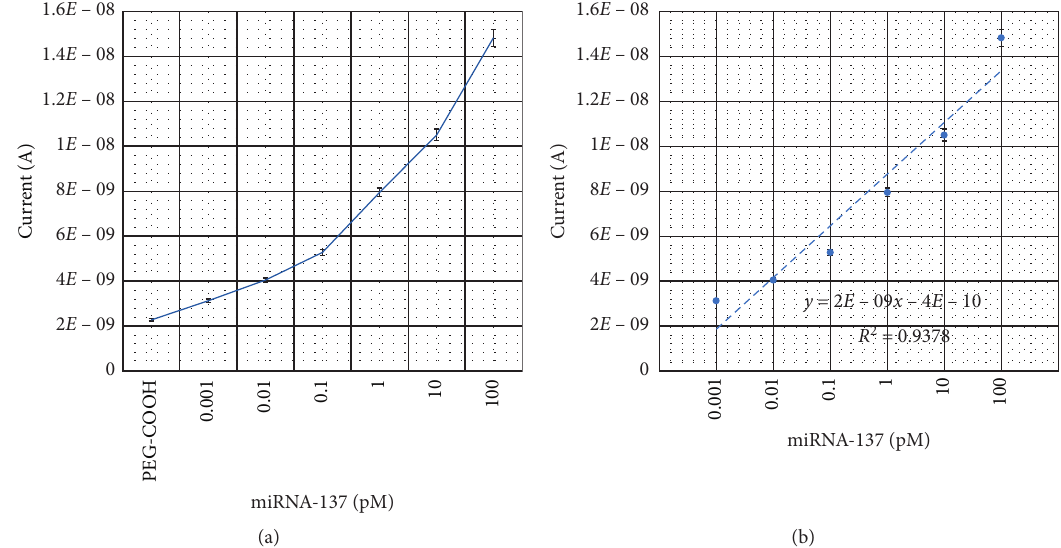
Figure 4: (a) Current response of miRNA-137 hybridization. With increasing target miRNA-137 concentrations, current responses increased gradually. (b) Difference in current response hybridization. miRNA-137 and its complementations are plotted. Detection limit was calculated as